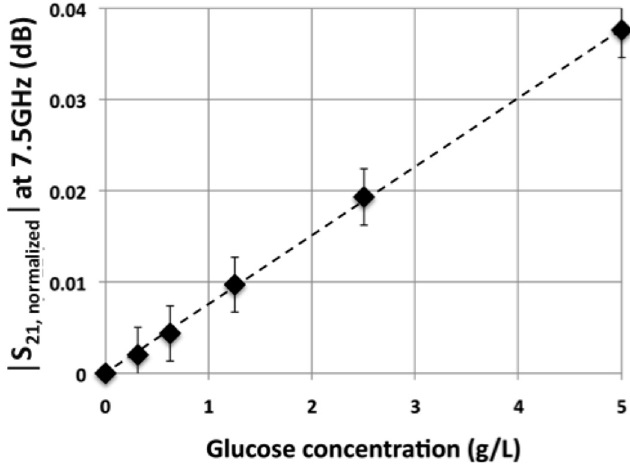
Figure 6. Modulus of the normalized S21 parameter at 7.5 GHz as a function of the glucose concentration.